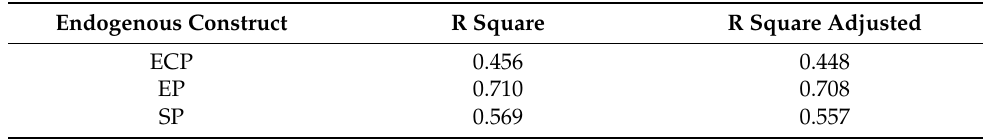
Table 6. Coefficient of determination (R 2